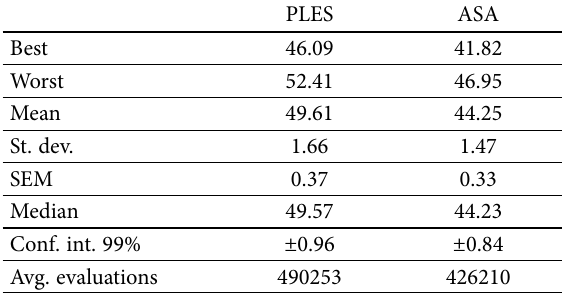
Table 9. Performance of the PLES and the ASA for